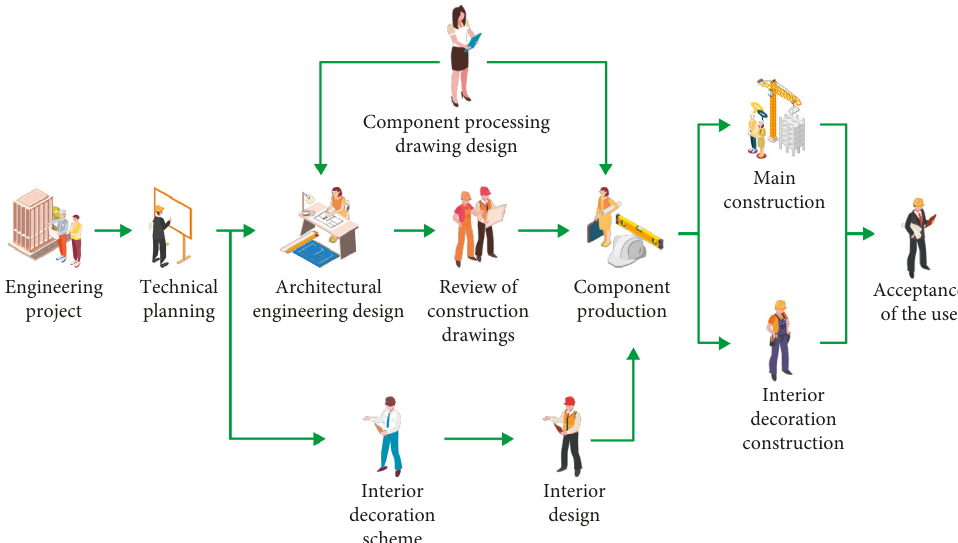
Figure 1: Assembly construction